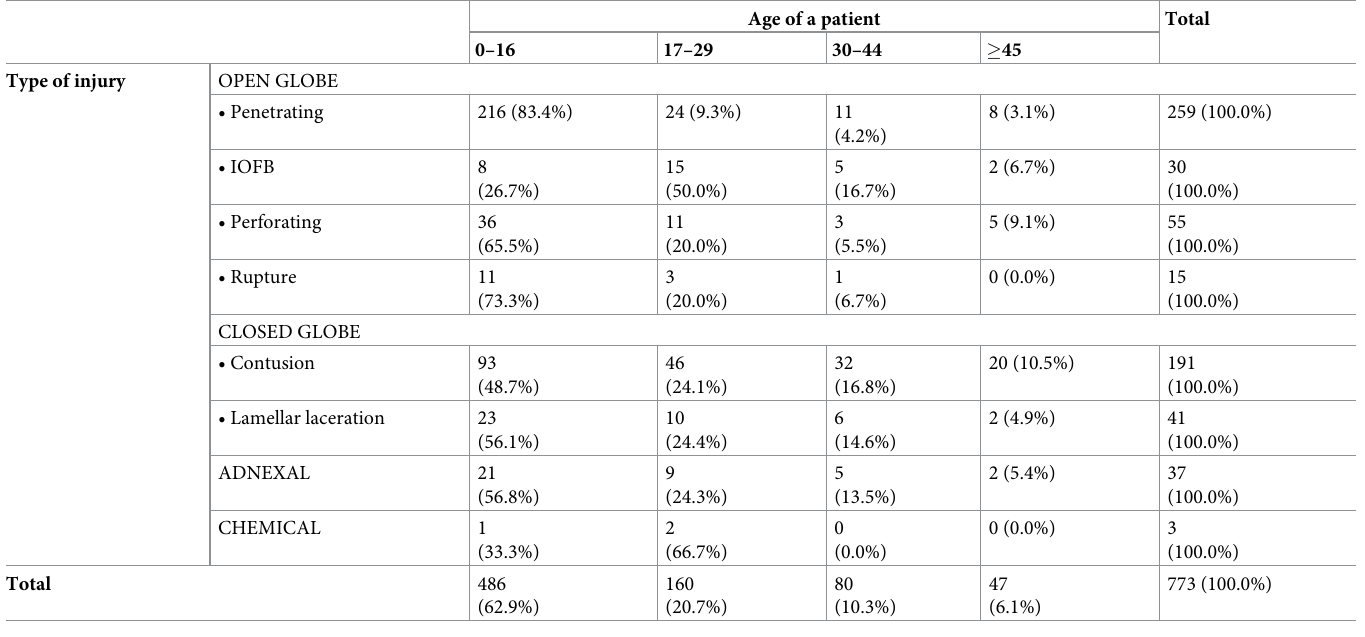
Table 2. Correlation between the type of ocular injury and age group of patients treated at Hawassa University, Referral Hospital, from January 01, 2012 to July 31, 2014 (N = 773).